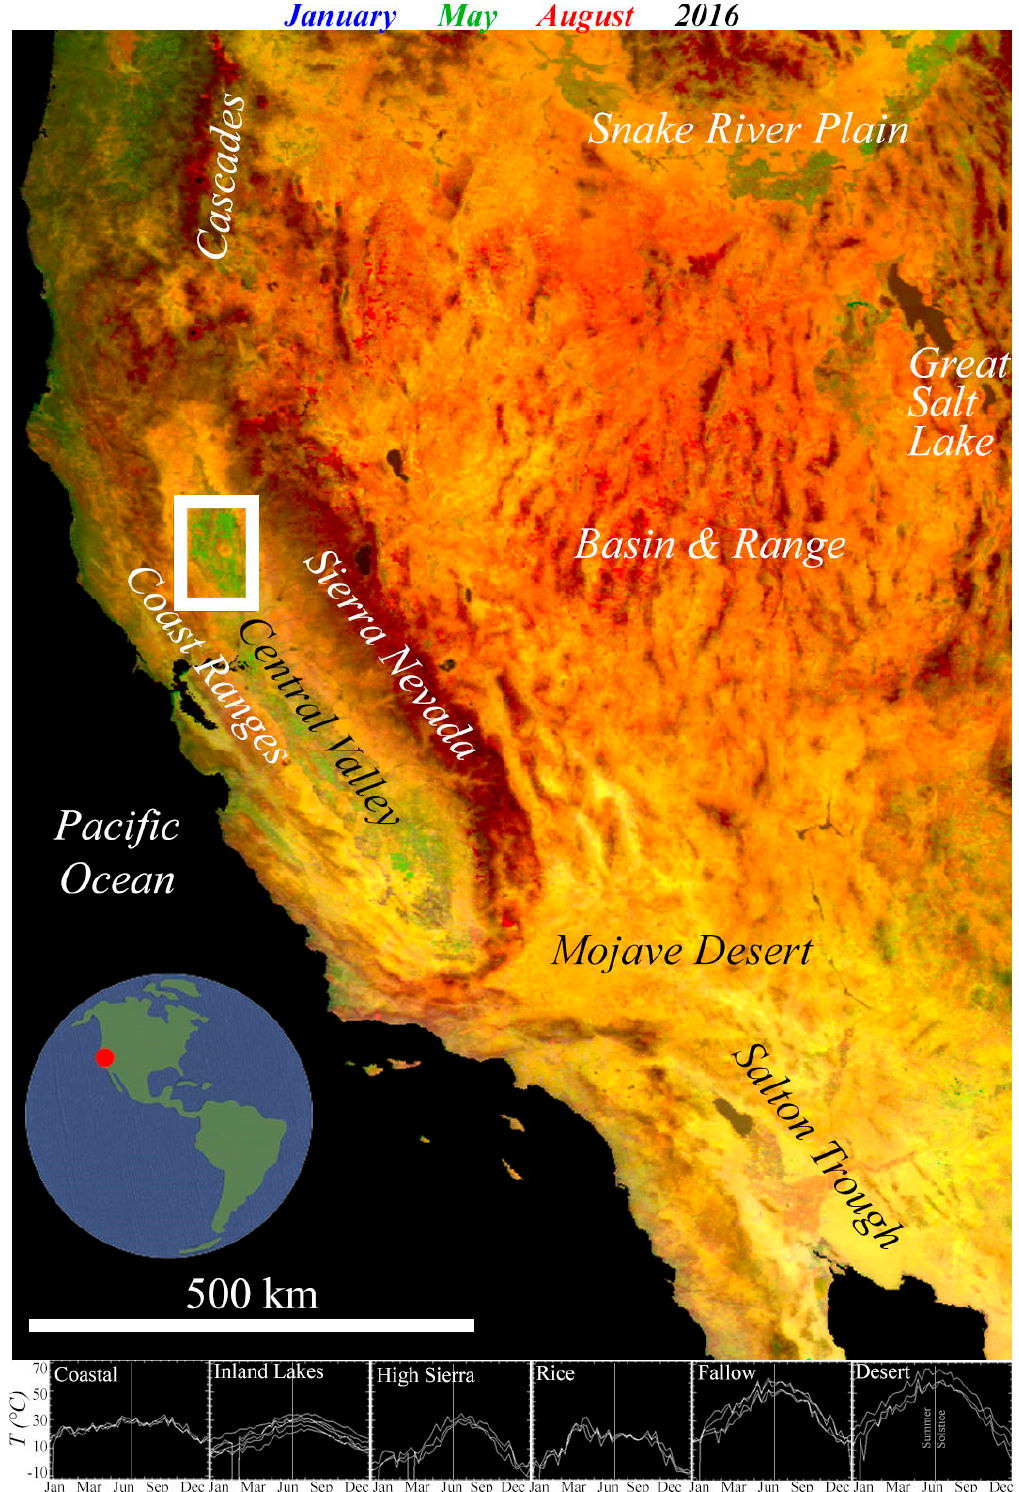
Figure 1. Thermal Phenology of the Western United States of America. The Central Valley lies between the Pacific Ocean and the hyperarid Basin & Range and Mojave Desert. Arid regions appear red or yellow due to summer heating. Sierra Nevada and Cascades mountains appear dark red due to seasonal snowpack. Central Valley agriculture appears green because evapotranspiration (ET) of dense summer crops results in substantial August cooling. Example time series of annual temperature cycle shown for 6 biogeophysical regions.